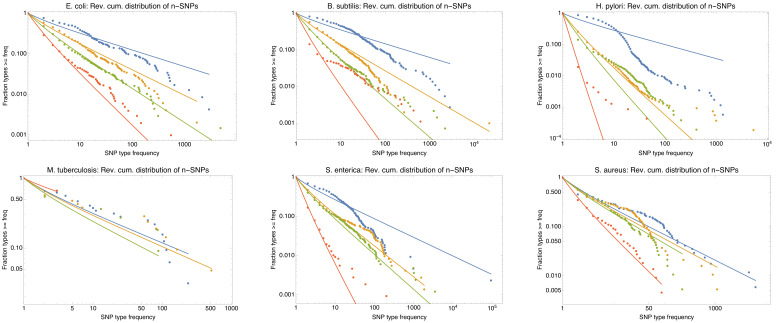
Power-law fits of the n-SNP distributions for all six species. Each panel shows the reverse cumulative distributions of the frequencies of all observed 2-SNPs (blue dots), 3-SNPs (orange dots), 4-SNPs (green dots), and 12-SNPs (red dots), with the solid lines in corresponding colors showing power-law fits. The species is indicated at the top of each panel.